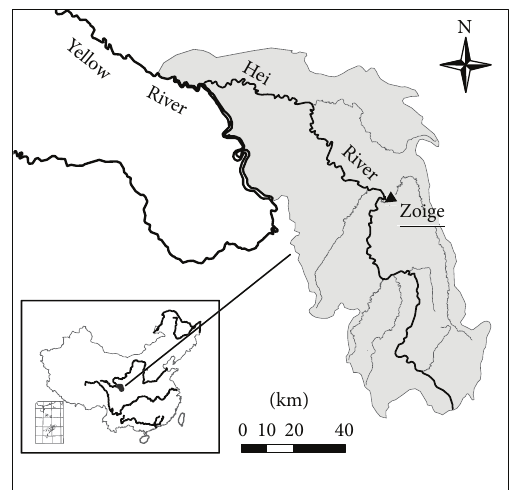
Figure 1: Location of the study